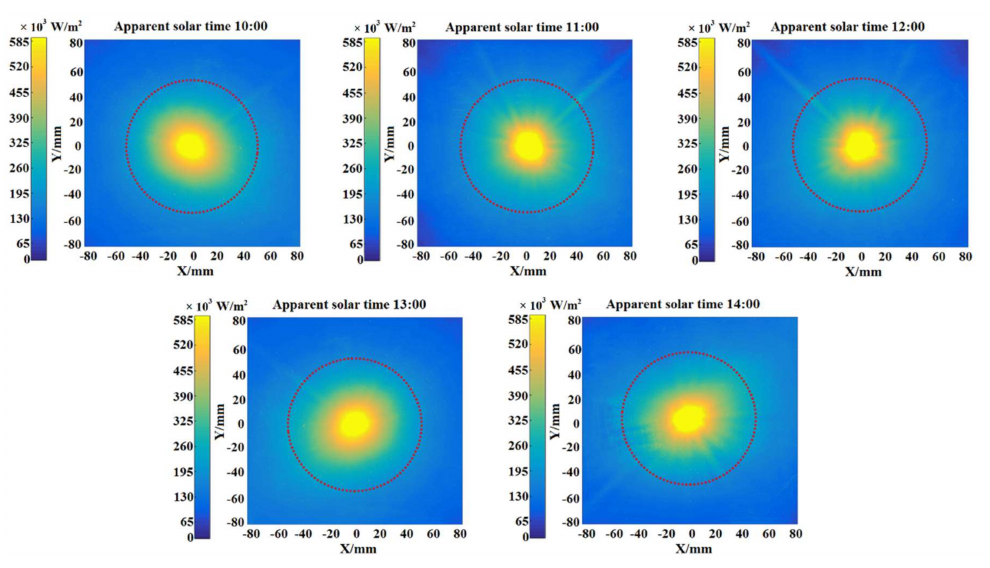
Figure 4. The flux density distributions of focal spot under different apparent solar times.